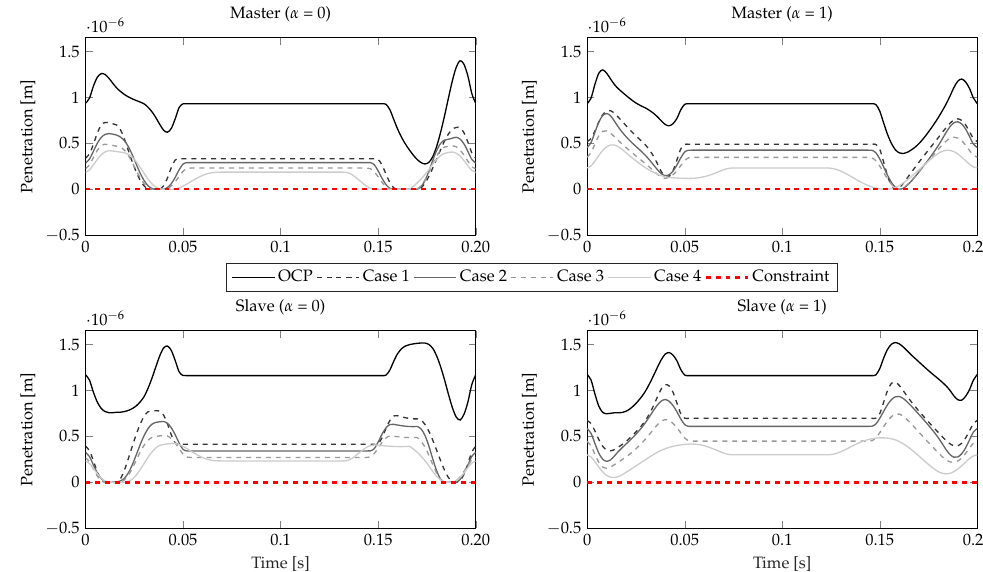
Figure 15. Co-design result: roller-cam bodies penetration.